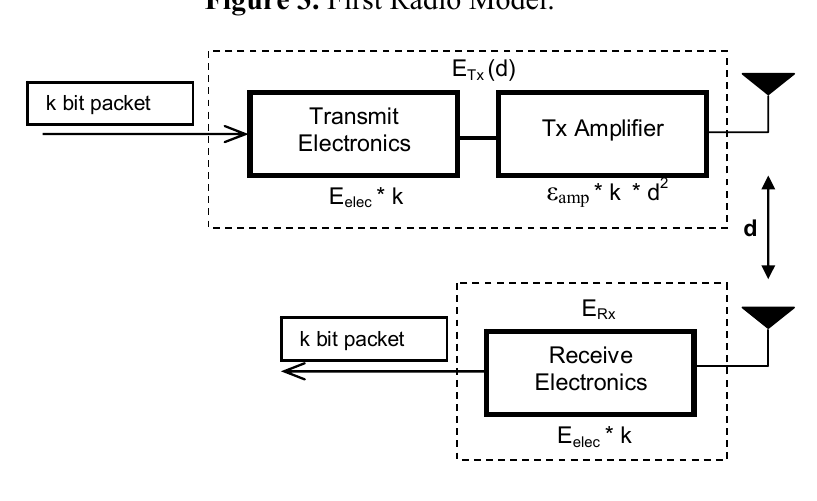
Figure 3. First Radio Model.